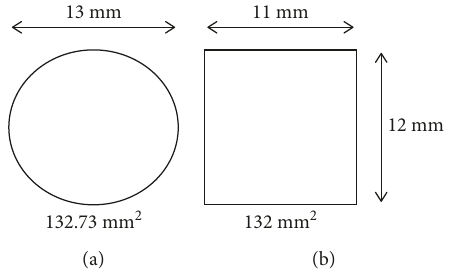
Figure 2: Cross section of reinforcing bars: (a) SD400 bar and (b) HMSB.